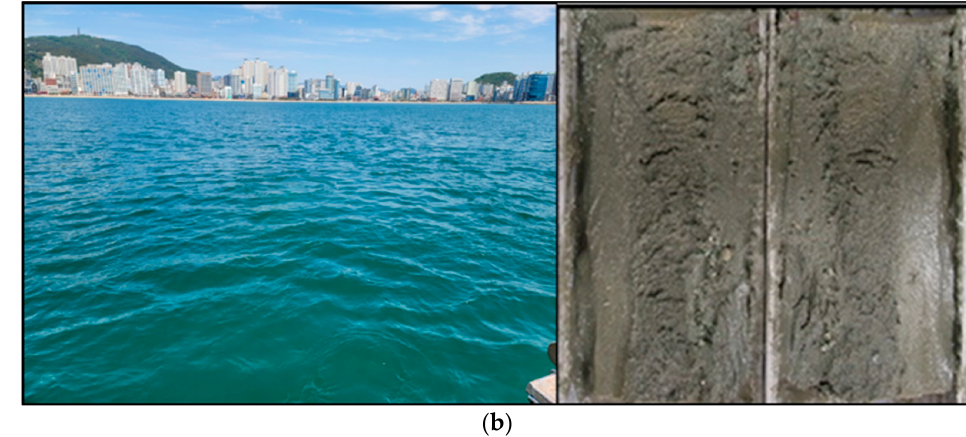
Figure 2. Photographs of the experimental sites and sediment samples; ( a ) Site 1, ( b ) Site 2.